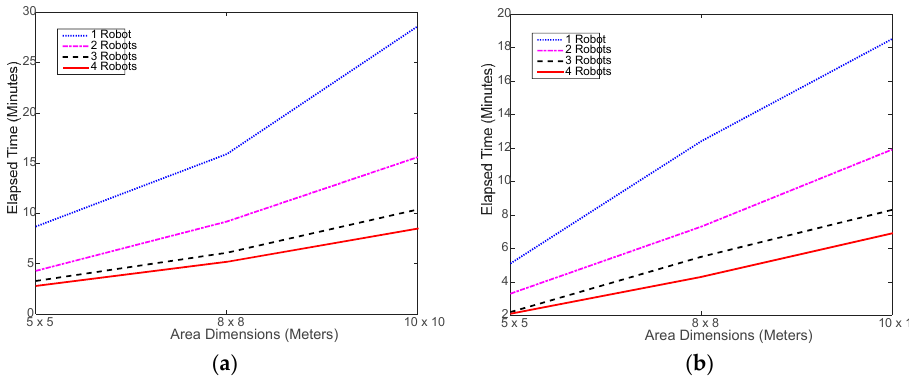
Figure 11. Simulated elapsed time of running the navigation and collecting required RSSI samples: ( a ) using distributed WiMAP algorithm; ( b ) using distributed DWiMAP.